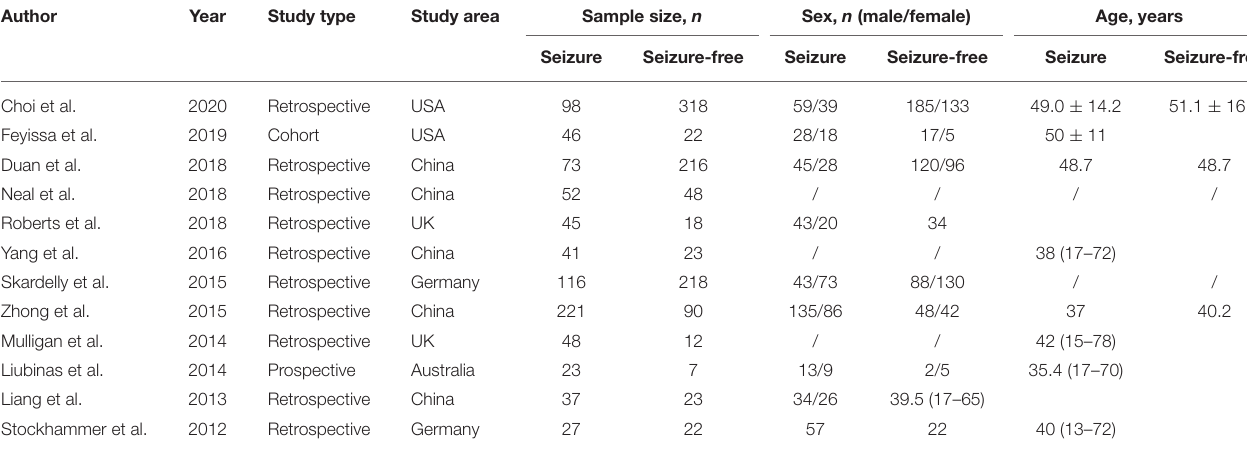
TABLE 2 | Characteristics of the included studies.